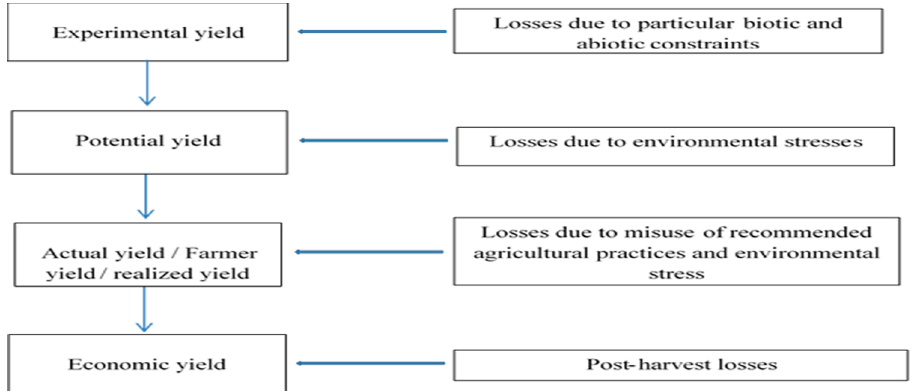
Figure 1. Different types of yields from maize production. Figure 1. Di ff erent types of yields from maize